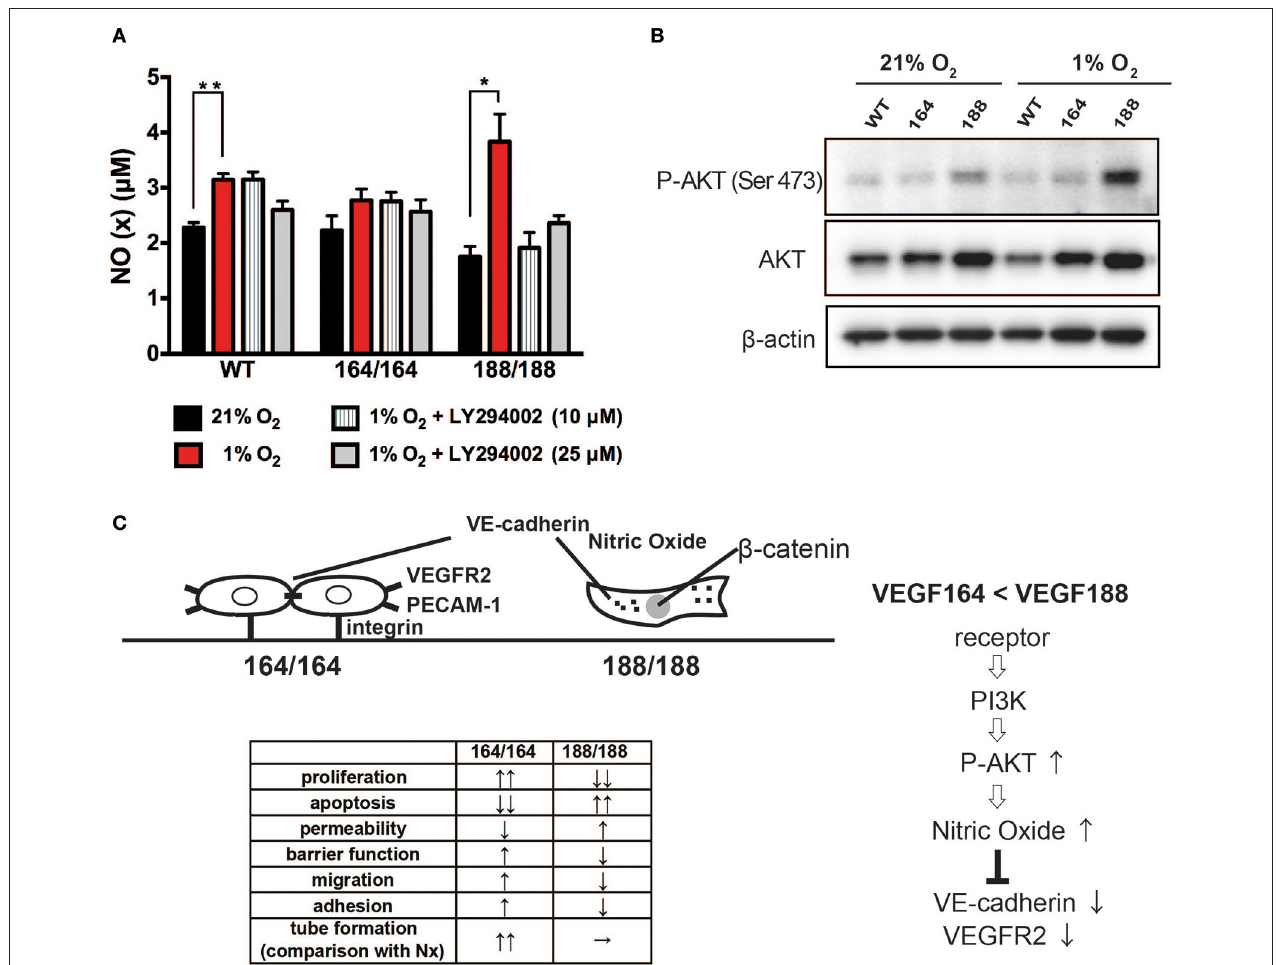
FIGURE 4 | VEGF isoform contribution to nitric oxide generation by endothelial cells through PI3 kinase/Akt signaling during hypoxia. (A) NO (x) levels in cell conditioned medium of EC exposed to 21 or 1% O 2 for 24h, with or without 1h of LY294002 pre-treatment at the indicated concentration. Data shown are average ± SEM ( n = 3); three wells, each containing cells isolated from 2 to 3 mice. * P < 0.05, ** P < 0.005. (B) Western blot of whole cell extracts from endothelial cells treated for 24h at 21 or 1% O 2 were probed with phospho-Akt at Ser473, total Akt, or β -actin antibodies. (C) Schematic representation of plausible differential signaling in endothelial cells exclusively expressing VEGF164 or